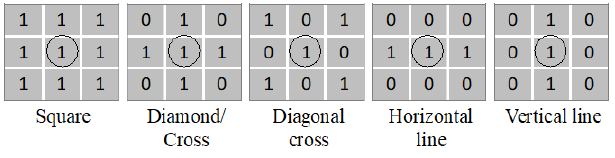
Figure 3. Effect of the morphological